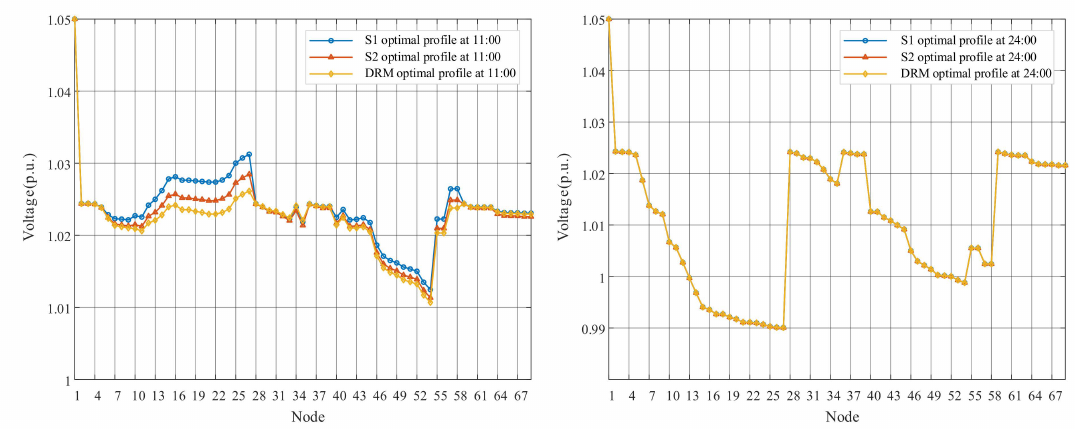
Figure 13. The nodal voltages of 11:00 and 24:00 from three strategies.